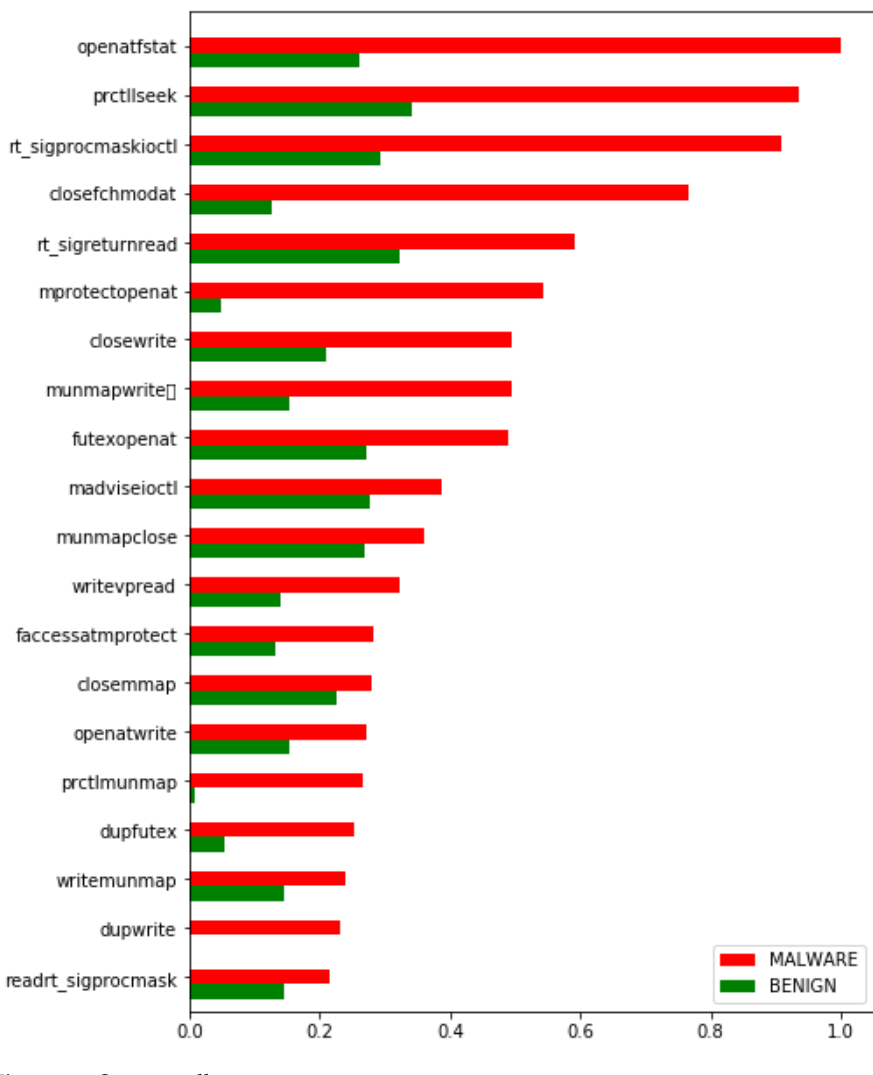
Figure 10. System call sequence.